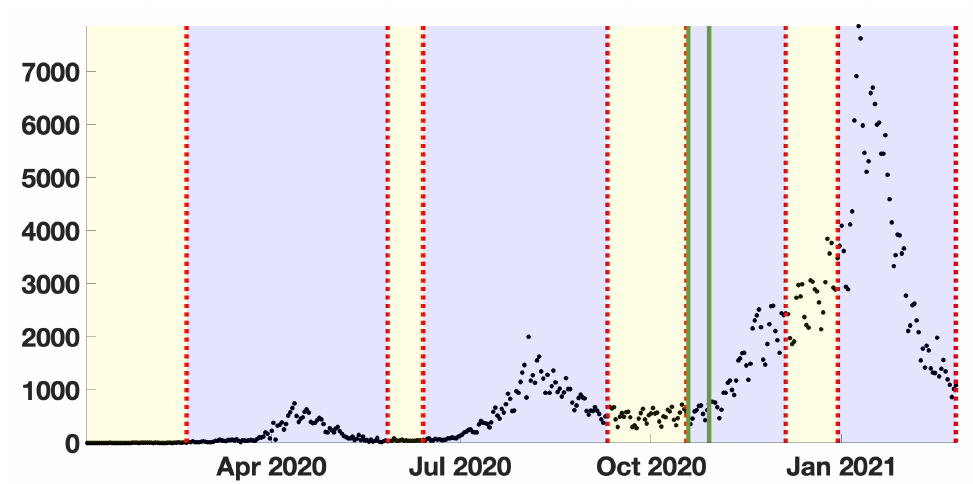
Figure 4. In this figure, we plot the daily number of reported cases for COVID-19 in Japan.